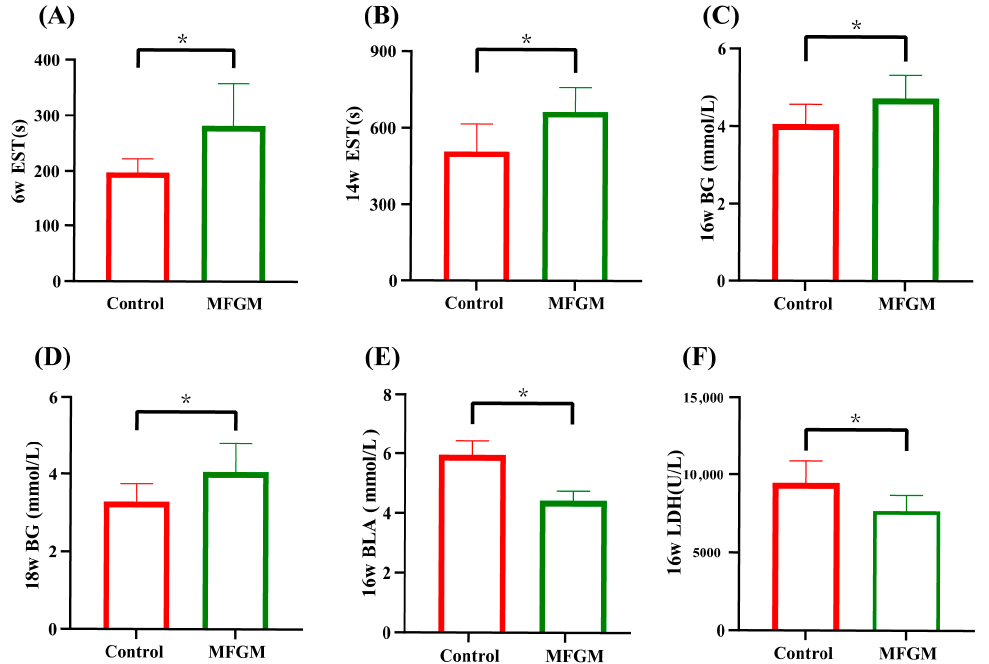
Figure 2. Effects of milk fat globule membrane on the swimming test and biochemical indices in blood serum: ( A ) exhaustive swimming time (EST) of the mice in different groups at 6 weeks; ( B ) exhaustive swimming time (EST) of the mice in different groups at 14 weeks; ( C ) content of blood glucose (BG) from the mice in different groups after the free swimming test at 16 weeks; ( D ) content of blood glucose (BG) from the mice in different groups at 18 weeks; ( E ) content of blood lactic acid (BLA) from the mice in different groups after the free swimming test at 16 weeks; and ( F ) content of lactate dehydrogenase (LDH) from the mice in different groups after the free swimming test at 16 weeks. The data are expressed as mean ± SD, n = 8, * p < 0.05. Control: fed with saline; MFGM: fed with 400 mg/kg BW milk fat globule membrane.